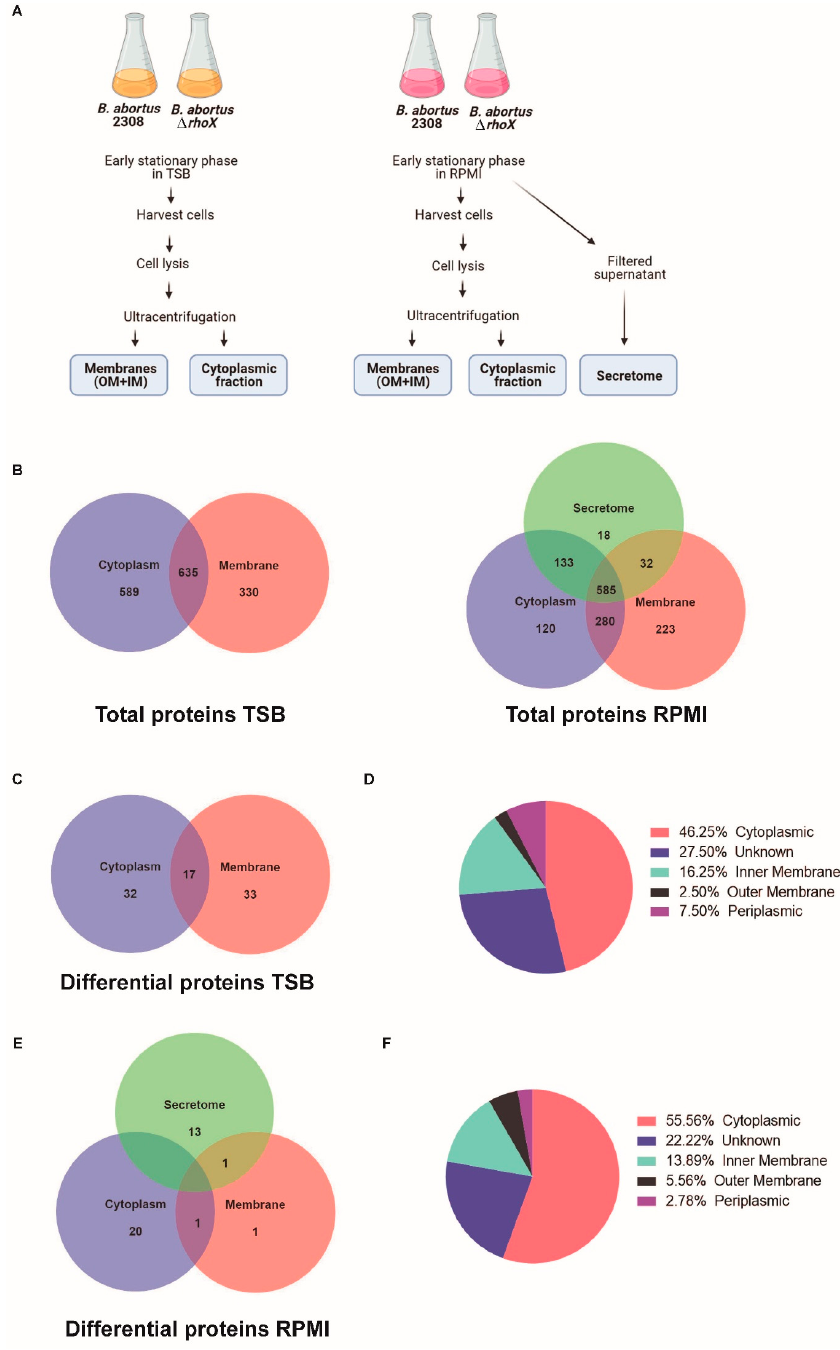
Figure 5. Quantitative proteomics screen to identify substrate repertoire of RhoX. Early stationary phase cultures of the indicated strains grown in TSB or in RPMI media were processed as described in methods, and the indicated subcellular fractions analyzed by LC-MS/MS ( A ) . Venn diagrams showing the total number of identified proteins in the indicated cellular fractions (left: TSB-grown bacteria; right: RPMI-grown bacteria) ( B ). Venn diagram showing the distribution of differentially represented proteins of TSB-grown bacteria ( C ). Proteins differentially represented (82) between 2308 and ∆ rhoX (in cytoplasmic and membrane fractions of TSB-grown bacteria) were grouped by their predicted localization according to PSORTb ( D ) . Venn diagram showing the distribution of differentially represented proteins of RPMI-grown bacteria ( E ). Proteins differentially represented (36) between 2308 and ∆ rhoX (in cytoplasmic, secretome and membrane fractions of RPMI-grown bacteria) were grouped by their predicted localization according to PSORTb ( F